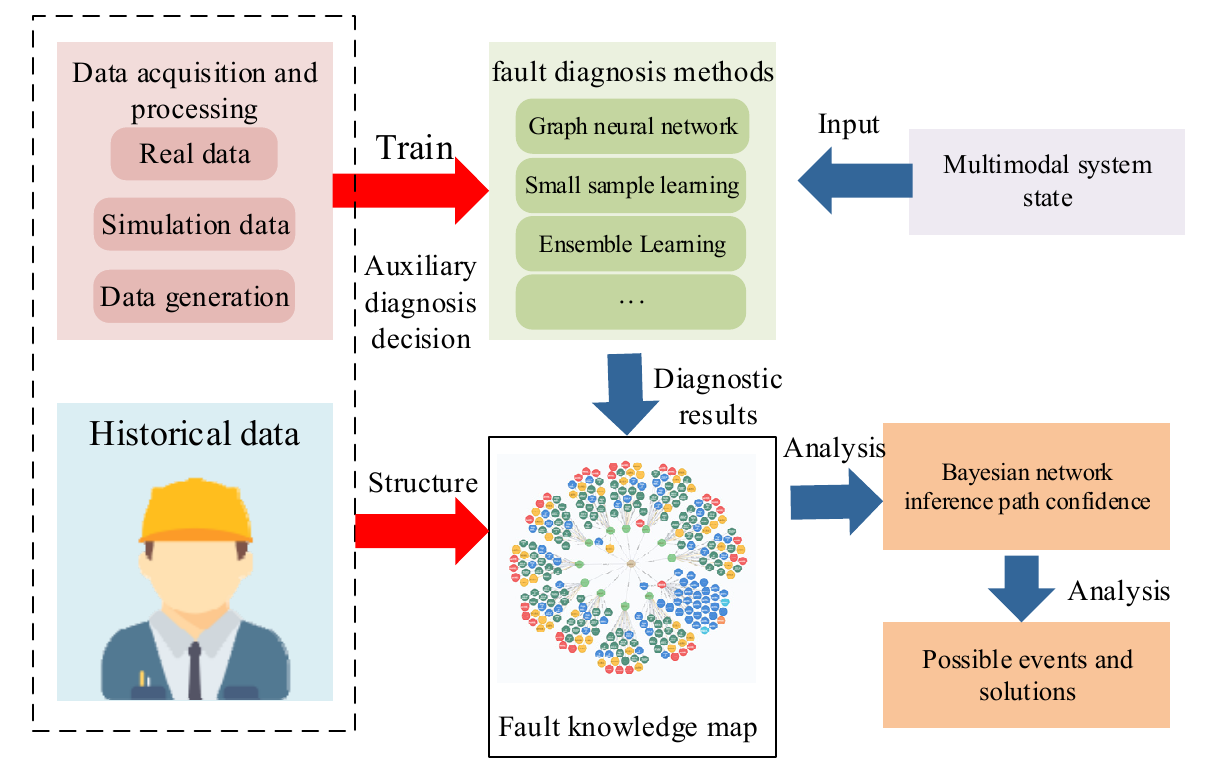
Figure 7. Fault diagnosis flow chart.